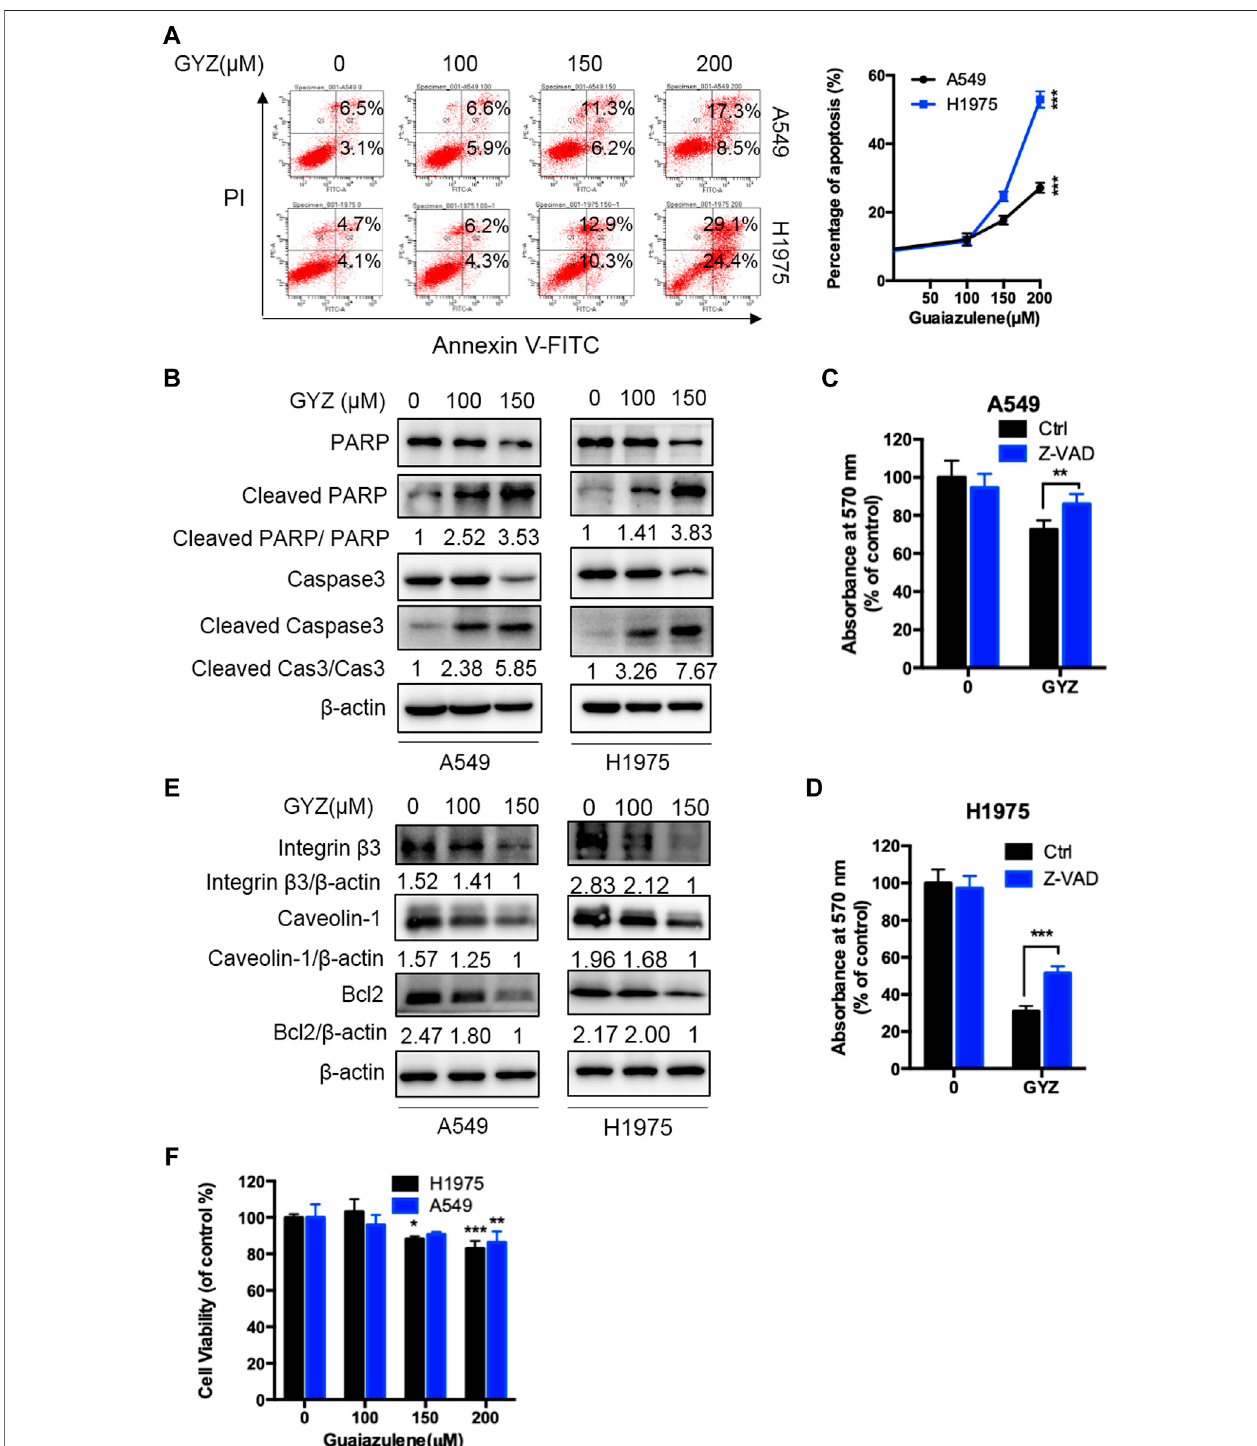
FIGURE 2 | GYZ triggers apoptosis in NSCLC cells. (A) annexin V – FITC/PI staining was used to detect the apoptotic effects induced by GYZ in NSCLC cells. (B) ImmunoblotanalysisofCleavedPARP,PARP,CleavedCaspase3,Caspase3expressioninNSCLCcellstreatedwiththeindicatedconcentrationsofGYZfor48 h. (C,D) The MTT assay determined cell growth of NSCLC cells treated with GYZ (150 μ M) in the absence or presence of 10 μ M Z-VAD for 48 h. (E) Immunoblot analysis of Integrin β 3,Caveolin-1, Bcl2 expression inNSCLC cellstreatedwiththeindicatedconcentrationsofGYZfor48 h. (F) GYZat theindicated concentrationsinduced anoikis in NSCLC cells that were cultured under detachment environment for 24 h. All data are means ± SD. * p < 0.05, ** p < 0.01, *** p < 0.001.